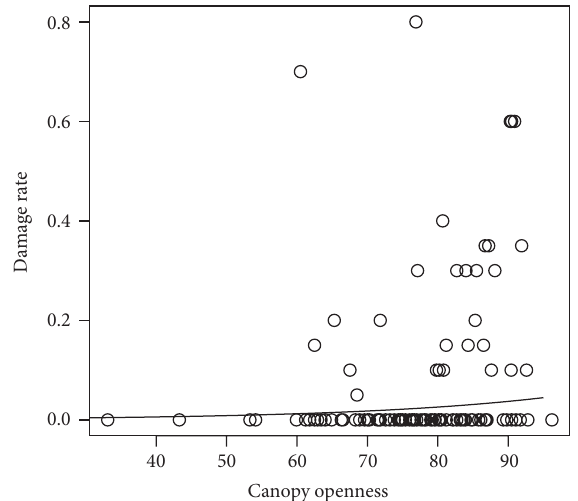
Figure 1: Relationship between canopy openness of resting sites in paddy fields and rate of damage to rice plants. Canopy openness (%) was calculated using a fisheye-lens camera and CANOPON software. Damage rate was calculated as the number of plants damaged by sparrows/total number of plants ( 𝑛 = 20 in each study